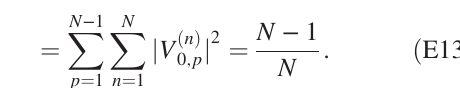
and r [plot shows exp ð 2 r Þ ] that int